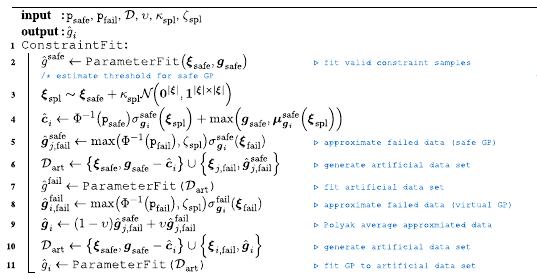
Algorithm1.Induce arti fi cialdatapointsto fi tGPondatasetswithfailed samples.